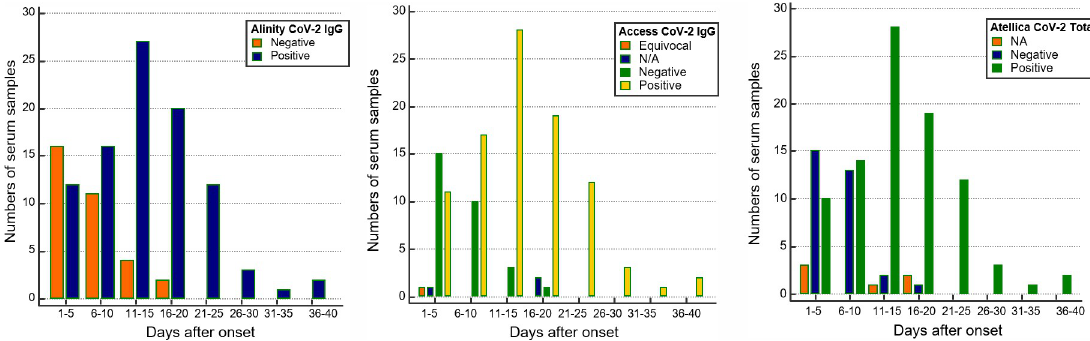
Fig 3. Samples with SARS-CoV-2 antibody levels at different time points after the onset of symptoms from patients who showed confirmed/indeterminate results of COVID-19 molecular tests. (A) Alinity CoV-2 IgG, (B) Access-CoV-2 IgG, and (C) Atellica CoV-2 Total antibody presented positive in all specimens after 21 days from symptom onset.